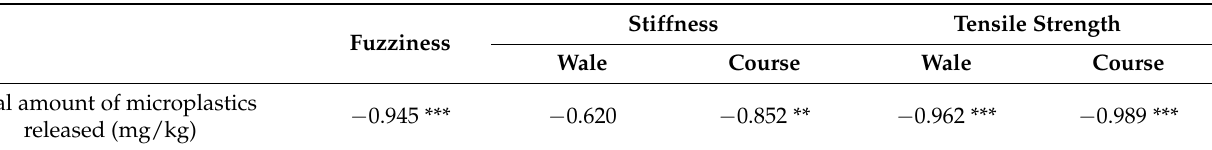
Table 4. Pearson’s correlation analysis results show correlations between the amount of the released microplastics and physical properties. Stiffness Tensile Strength Fuzziness Wale Course Wale Course Total amount of microplastics − 0.945 *** − 0.620 − 0.852 ** − 0.962 *** − 0.989 *** released (mg/kg) ** p < 0.01, *** p <